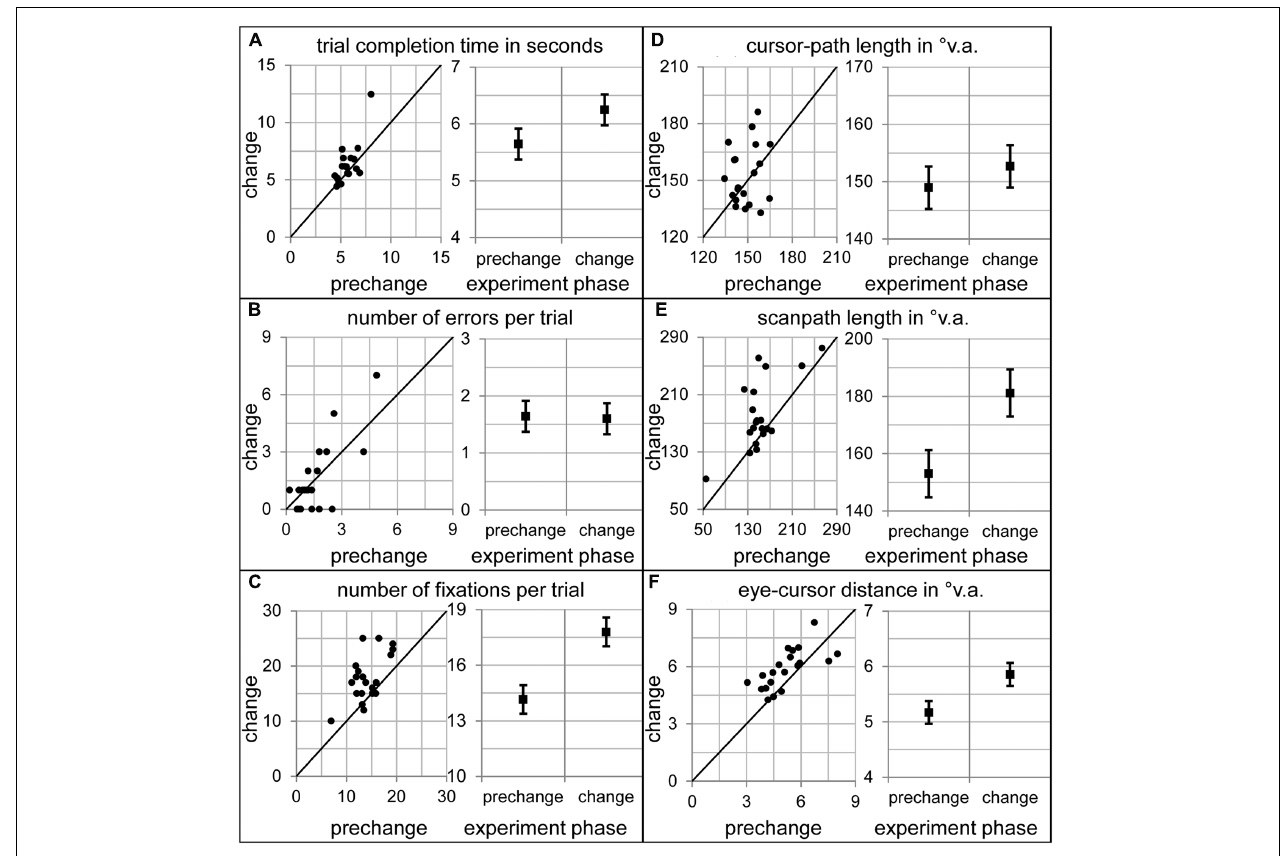
FIGURE 3 | Dependent variables during prechange baseline and during the first change trial. The left diagrams of all panels show the 20 participants’ individual data. The right diagrams of all panels show the sample means and the standard error of the paired mean differences. (A) Click completion time in seconds. (B) Number of errors per trial. (C) Number of fixations per trial. (D) Cursor-path length in ◦ v.a. (E) Scanpath length in ◦ v.a. (F) Eye-cursor distance in ◦